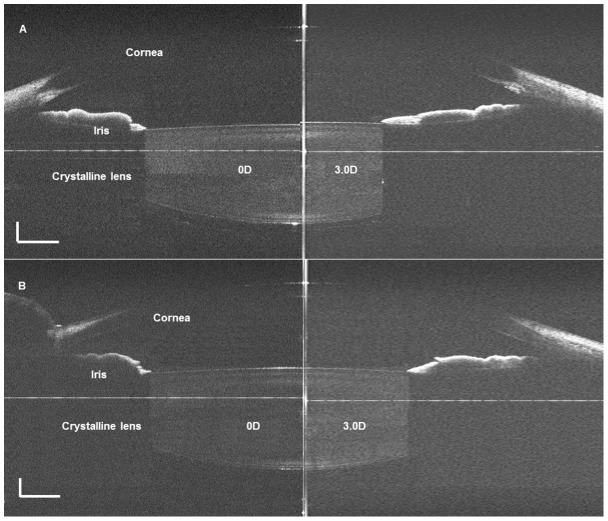
The comparison of OCT images obtained before (left) and after (right) accommodation on horizontal and vertical meridians.